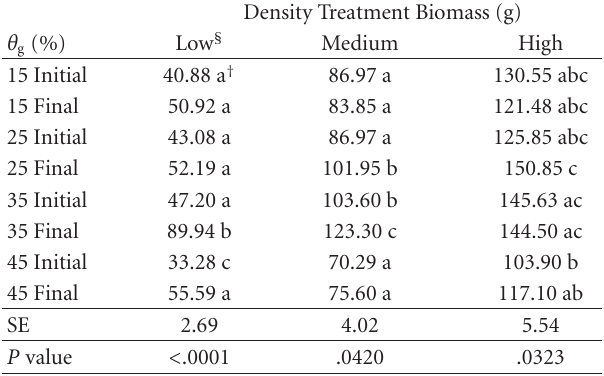
Table 2: Mean initial and final earthworm biomass in the low, medium and high earthworm densities according to θ g (%) treatment.